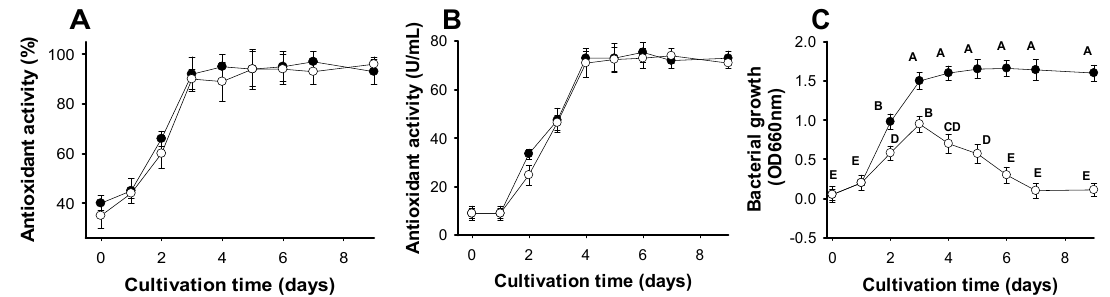
Figure 2. The effects of time and supplementary air on antioxidant activity ( A ), antioxidant productivity ( B ), and bacterial growth ( C ) via fermentation with Paenibacillus sp. TKU042, using SPP as the sole C/N source. (- -): supplementary air once per day (-o-): no supplementary air; Least significant difference ( α = 0.1) = 0.2658, coefficient of variation = 14.87304, triplicates for each experiment (n = 3), and means of IC 50 values with the same letter are not significantly different in comparison based on t -test